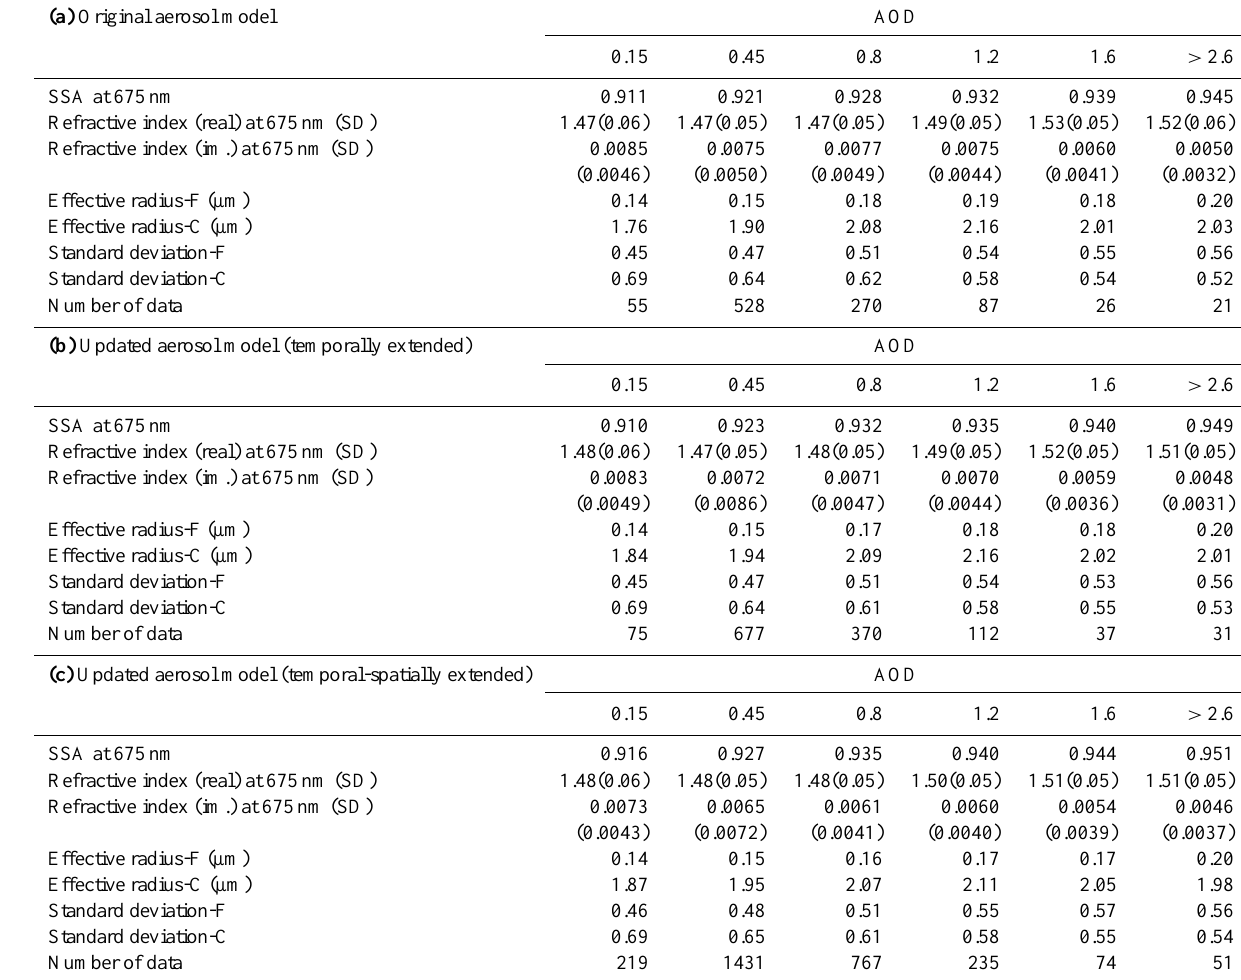
Table 2. Integrated AOPs for each AOD bin (550nm) from AERONET inversion data. Each of the AOD bins ranges between 0.0 and 0.3, (upper panel) were obtained from the original inversion data group, and those in the middle and lower panels (b and c) were estimated from temporally and temporal-spatially extended data sets, respectively. Fine and course modes are denoted by -F and -C, respectively. (a) Original aerosol